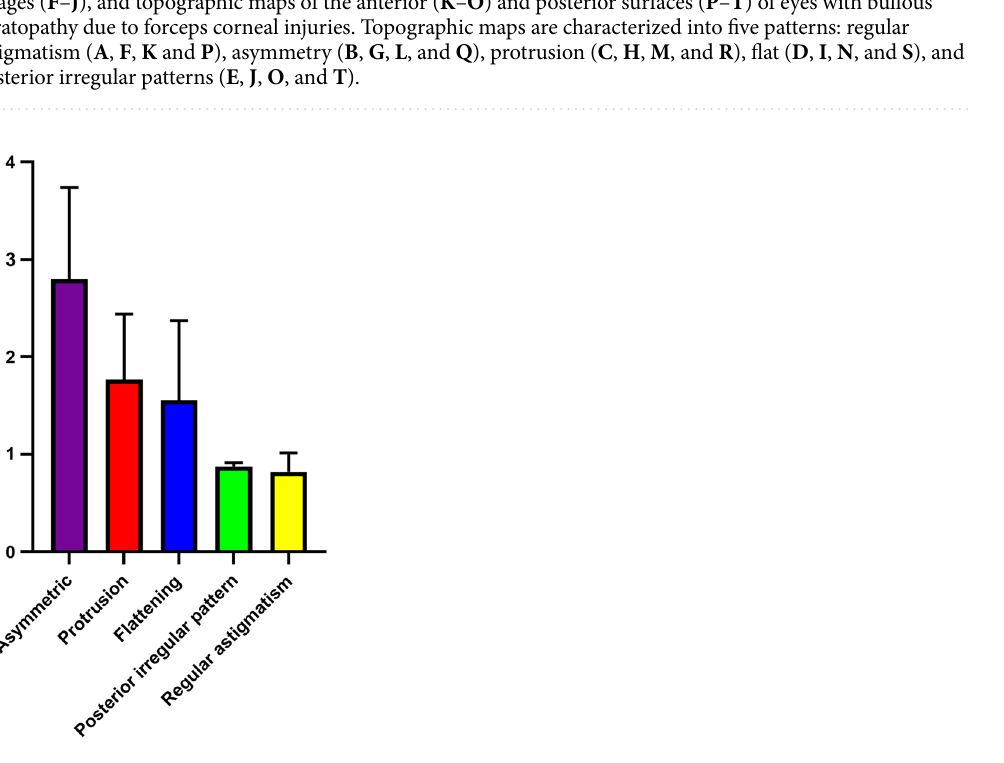
Figure 3. Comparison of corneal HOAs among various topographic map patterns. HOAs were measured for asymmetric, protrusion, flattening, regular astigmatism, and posterior irregular pattern respectively. HOAs tended to be higher for asymmetric, protrusion, and flattening than for regular astigmatism and posterior irregular pattern. However, due to small number, there was no significant statistical difference in each topographic map